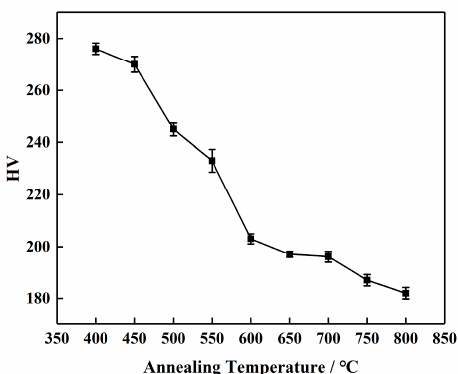
Figure 9. E ff ect of di ff erent annealing temperatures on microhardness of Ti 50 Ni 47 Fe 3 SMA.